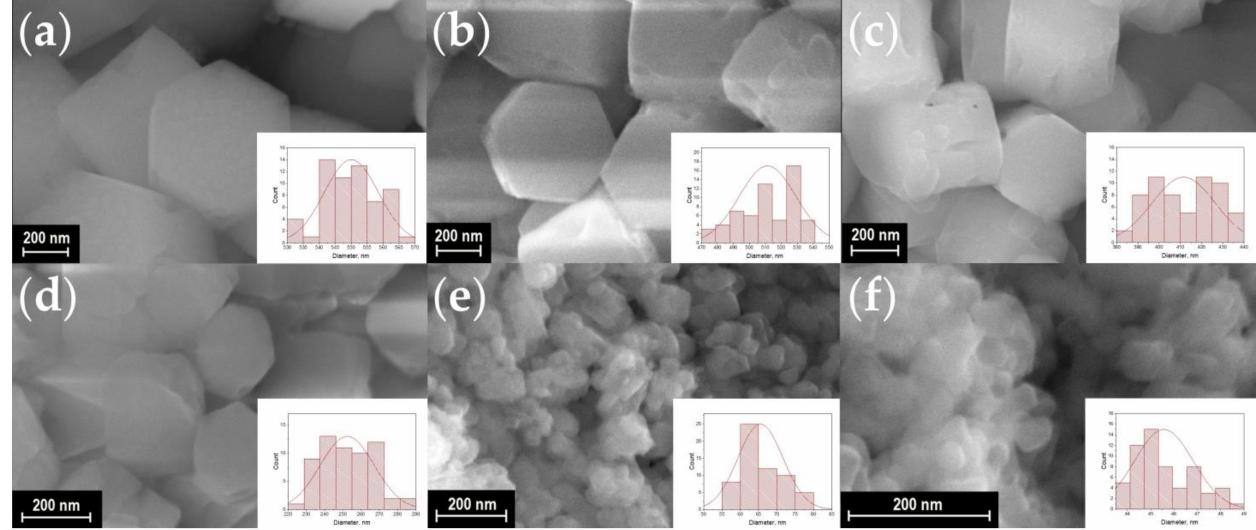
Figure 5. SEM images of the samples NaY 0.98 − x Sm 0.02 Gd x F 4 ( a – f ): x = 2, 5, 10, 20, 40, and 60 at.% Gd, respectively. Particle size distribution of the samples is shown in the insets. The average diameter of particles is equal to about 550 ± 9, 511 ± 18, 412 ± 15, 252 ± 15, 66 ± 6, and 46 ± 2 nm for the Gd 3+ concentration of 2, 5, 10, 20, 40, and 60 at.%,